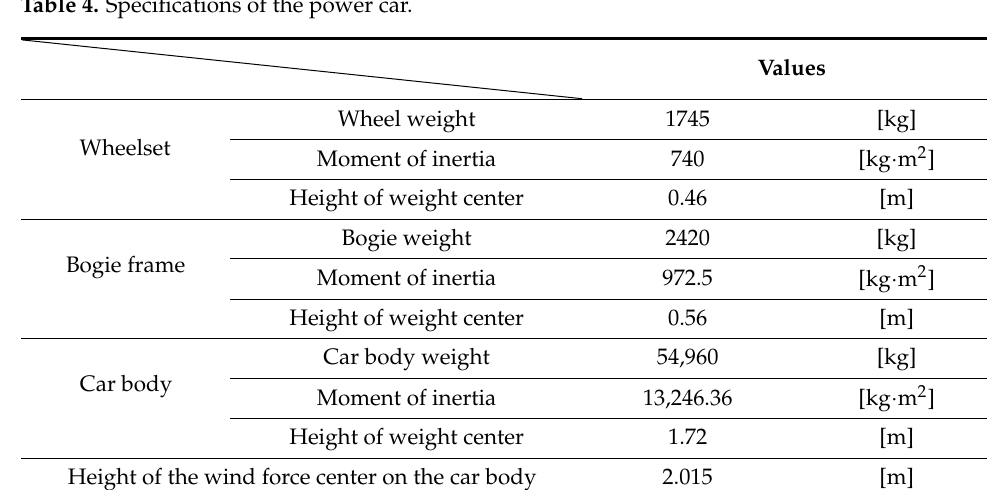
Figure 8. The 3D simulation model (Simpack). Table 4. Specifications of the power car.